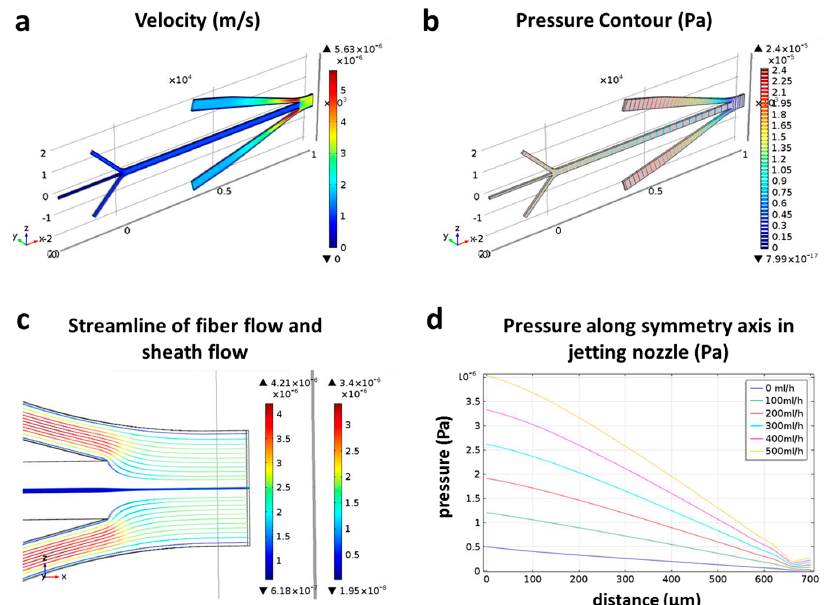
Figure 5. Simulation results. ( a ) Velocity distribution in the microchannel; ( b ) Pressure contour in microchannel; ( c ) Streamline of fiber flow and sheath flow; ( d ) Pressure distribution curves along symmetry axis of jetting nozzle under different flow rates of DI water.